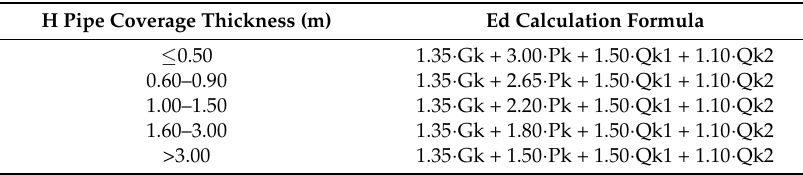
Table 6. Calculation